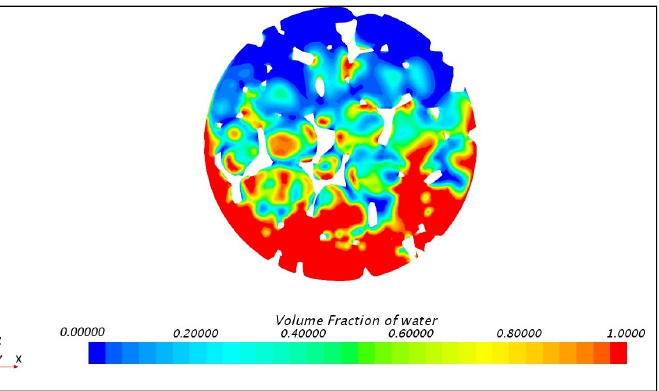
Figure 13. Distribution of liquid phase along the cross-section of the pipe with foam packing.